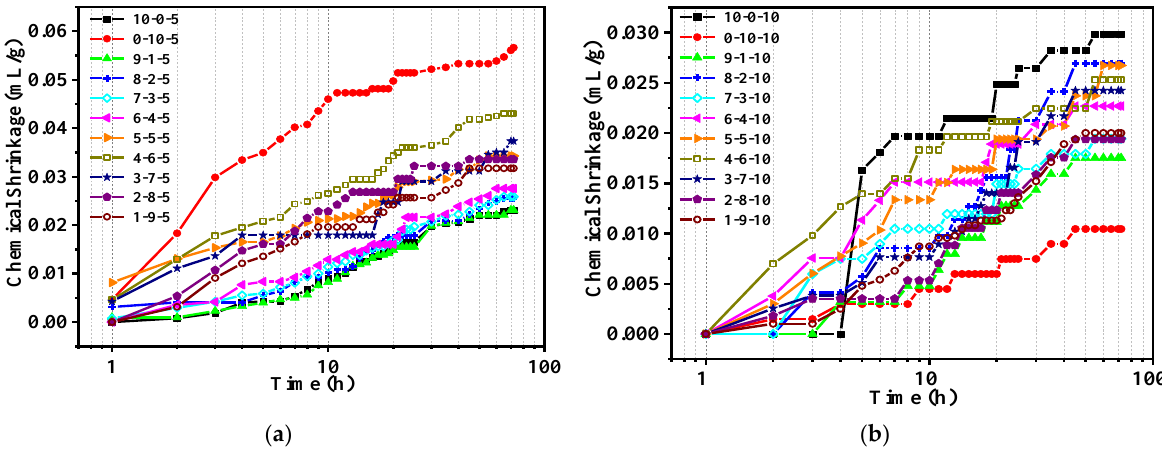
Figure 6. Chemical shrinkage of OPC-CSA-CS ternary systems: ( a ) with 5% CS; ( b ) with 10% CS. To better evaluate the influence of the addition of CS on the chemical shrinkage, the percentage was calculated by the difference between ternary blends and binary systems with the same OPC/CSA ratio based on the OPC-CSA system; the results are plotted in Figure 7. Positive values indicate an increase and negative values indicate a reduction. With the addition of 5% CS, the chemical shrinkage percentage of three groups, whose OPC/CSA ratios were 6/4, 5/5, and 4/6, respectively, showed a tendency to increase, while other groups showed a tendency to decrease. The largest increase of up to 70.6% appeared in the 6/4 ratio and the biggest reduction of up to 42.4% appeared in the 1/9 ratio. Likewise, for OPC-CSA-10%CS blends, the chemical shrinkage of most groups was decreased, ex- cept for the neat OPC, 8-2, and 4-6 systems. Additionally, the 6-4 group still displayed the largest rise in chemical shrinkage, while the pure CSA group showed the greatest reduc- tion of up to 83%. Moreover, in the situation where there was a high CSA proportion (OPC/CSA < 5/5), the chemical shrinkage of ternary systems decreased with the decrease in the OPC/CSA ratio regardless of the CS dosage. By contrast, there was no obvious pat- tern of change in the case of a high OPC proportion. -80-60-40-20020 406080 1 - 92 - 83 - 7 4 - 65 - 5 6 - 47 - 38 - 2 9 - 1CAS P e r c e n t a g e ( % ) With 5% With 10% OPC Figure 7. Comparison of chemical shrinkage of the OPC-CSA-CS and OPC-CSA systems at 72 h. Similarly, the effect of the OPC/CSA ratio on the chemical shrinkage of ternary bind- ers at a fixed CS content is plotted in Figure 8. It can be seen that based on the OPC-CS